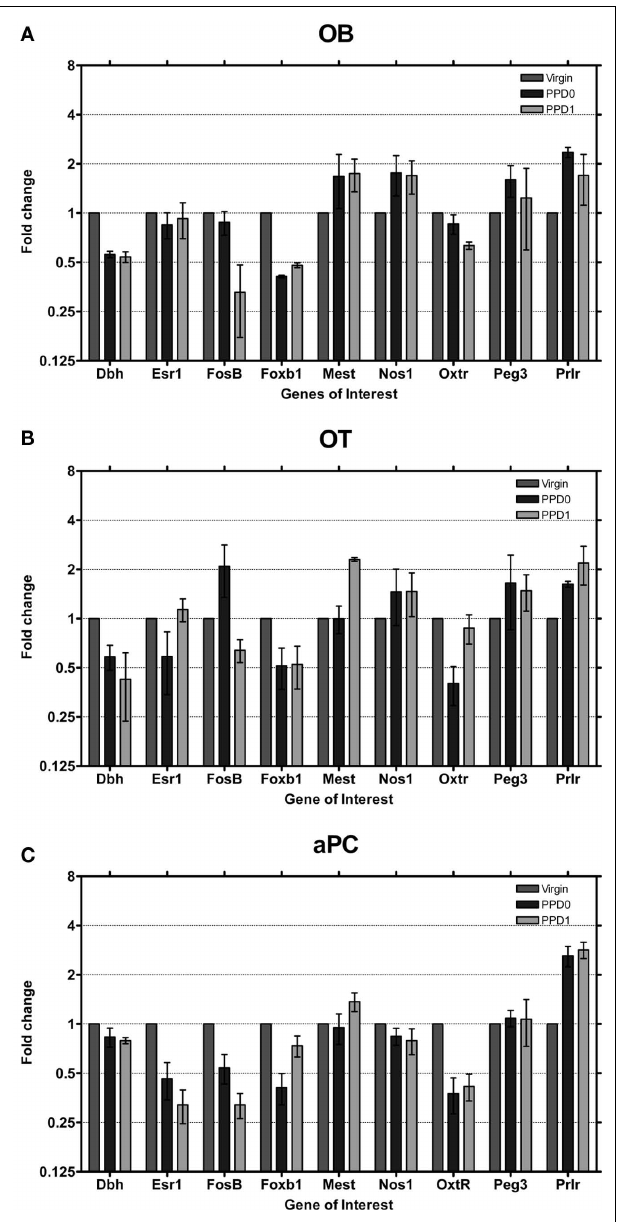
FIGURE 4 | Changes in fold expression (determined by C T method) at PPD0 and PPD1 in the (A) aLA, (B) pLA, and (C) EC. Mean ± SD are plotted on a log2 scale, such that fold increases and decreases are represented